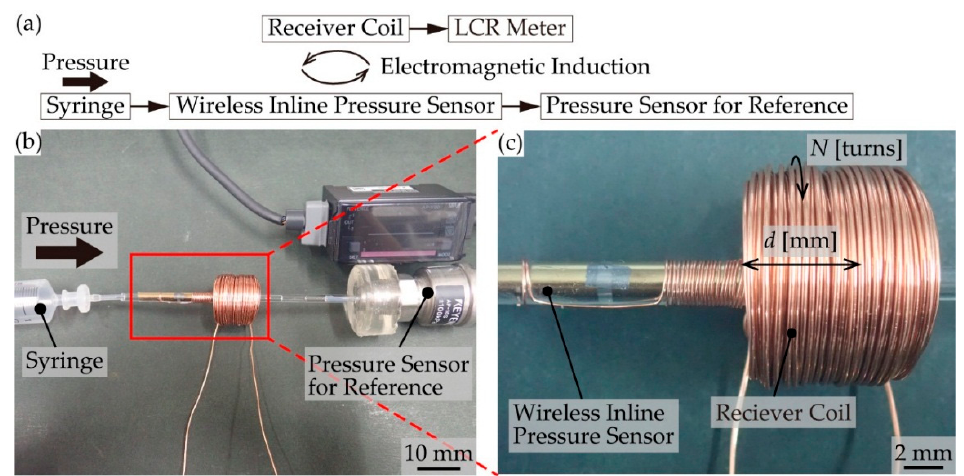
Figure 6. The measurement setup. ( a ) A schematic diagram. ( b ) A photographic image. ( c ) The fabricated wireless inline pressure sensor.